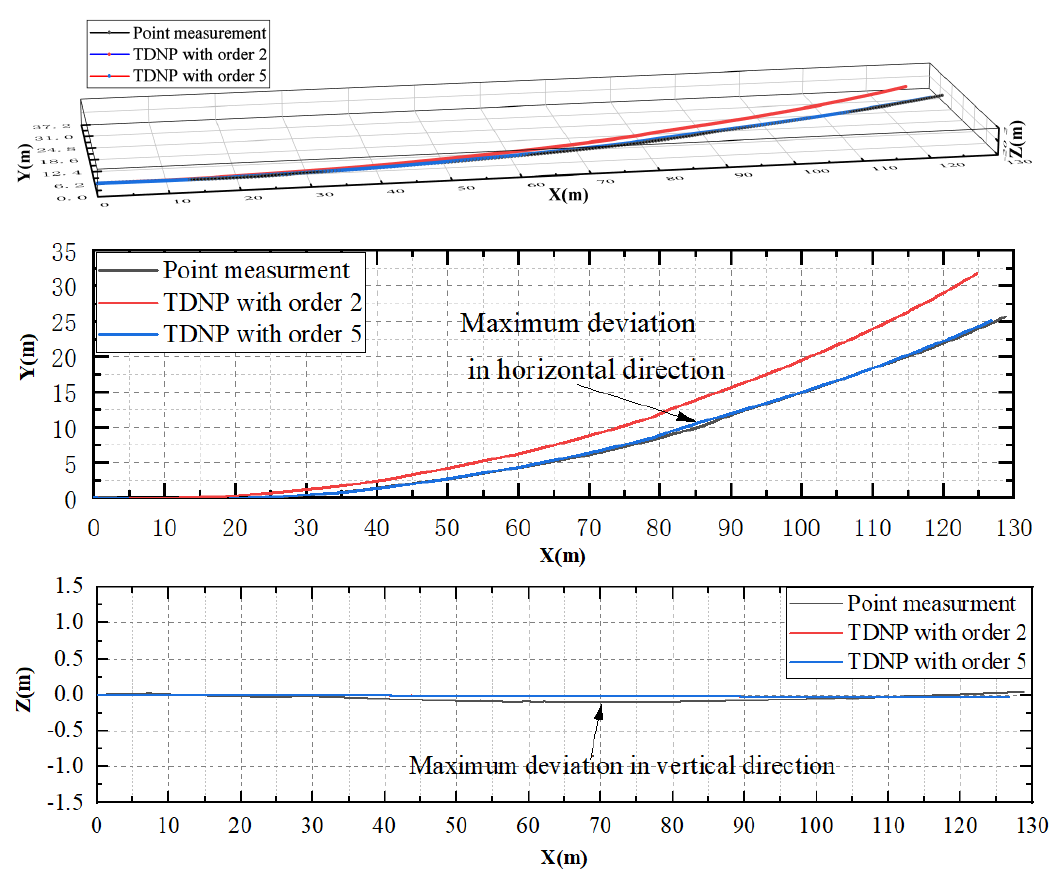
Figure 15. Field test